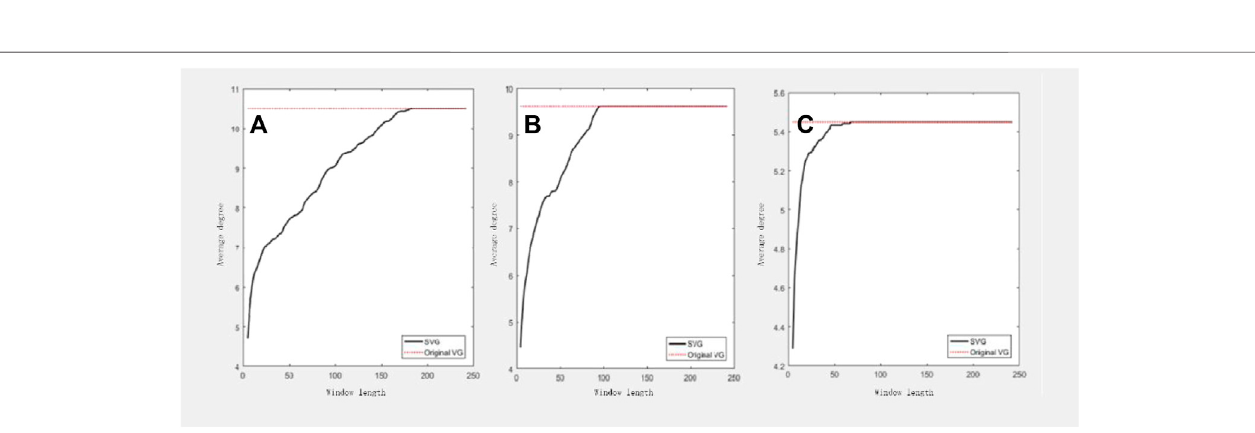
FIGURE5| RelationshipsbetweentheaveragedegreeoftheobtainedcomplexnetworkthroughSVGandthesliding-windowlengthfordifferenttypes (A) Original data; (B) Brownian Motion incorporated (C) Gaussian white noise considered.